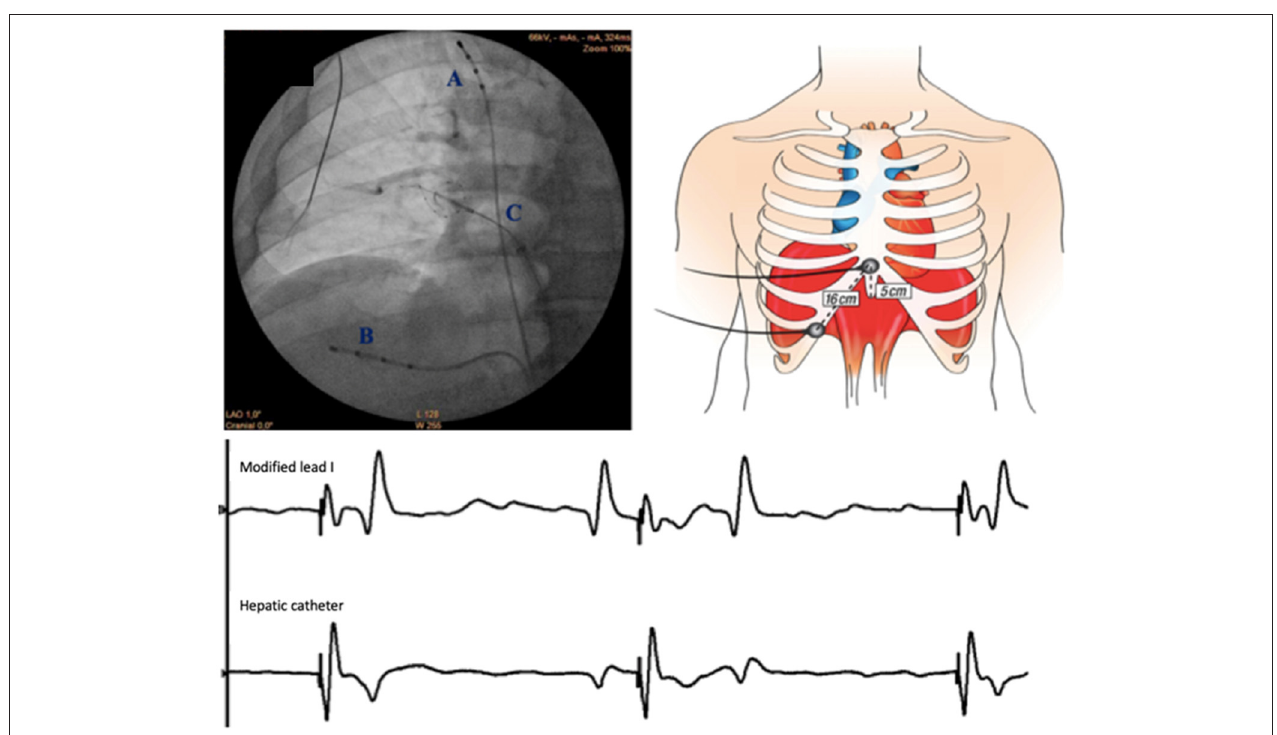
FIGURE 1 | Set up for CMAP recording. Left upper : Catheters positions on an antero-posterior fluoroscopic view (A. pacing catheter in superior vena cava; B. recording quadripolar catheter in subdiaphragmatic hepatic vein; C. cryoballoon and Achieve catheter). Right upper : Configuration of surface electrodes to obtain modified lead I: the right arm electrode was placed 5cm above the xyphoid process ant the left arm electrode along the right costal margin spaced 16cm apart the xyphoid. Lower : simultaneous CMAP recordings with modified lead I and hepatic catheter. Sweep speed is 100 mm/s. The phrenic nerve is paced with a cycle length at 1,000 ms